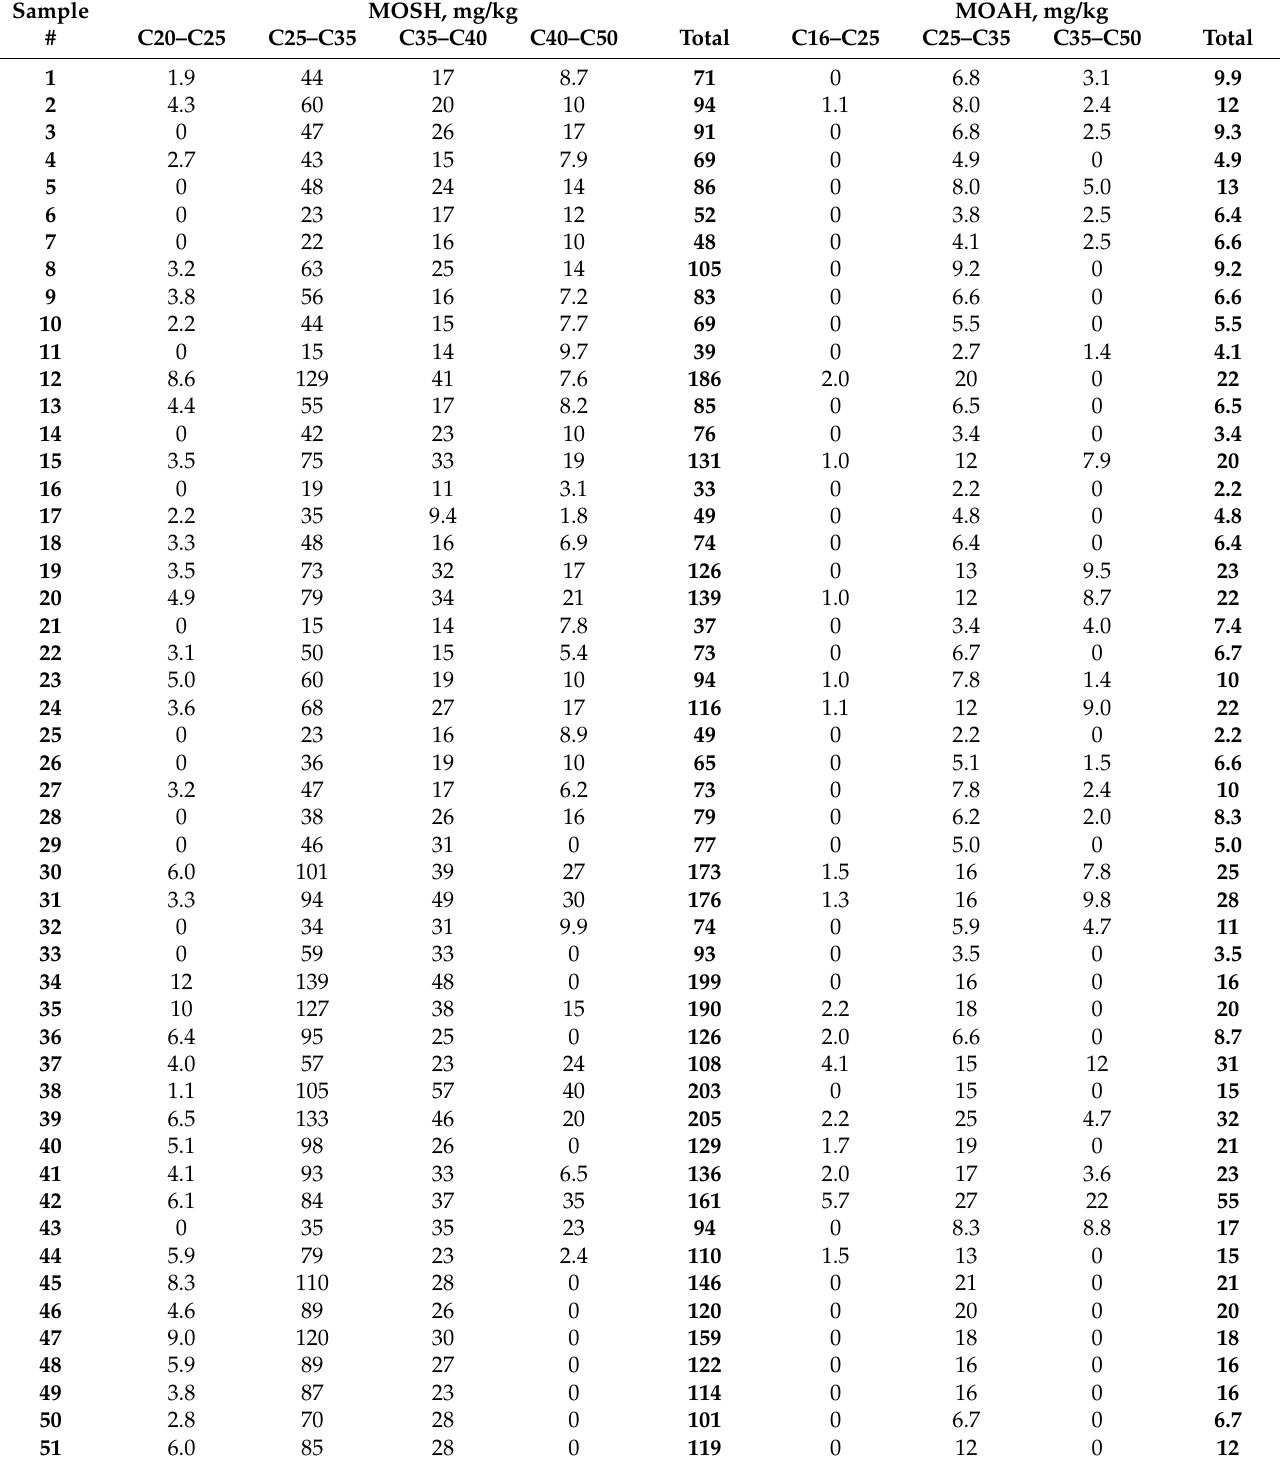
Table 3. Mineral oil saturated hydrocarbon (MOSH) and mineral oil aromatic hydrocarbon (MOAH) content in commercial olive pomace oils. Results, in mg/kg and with two significant figures, are given for the C-fractions and for the sum of